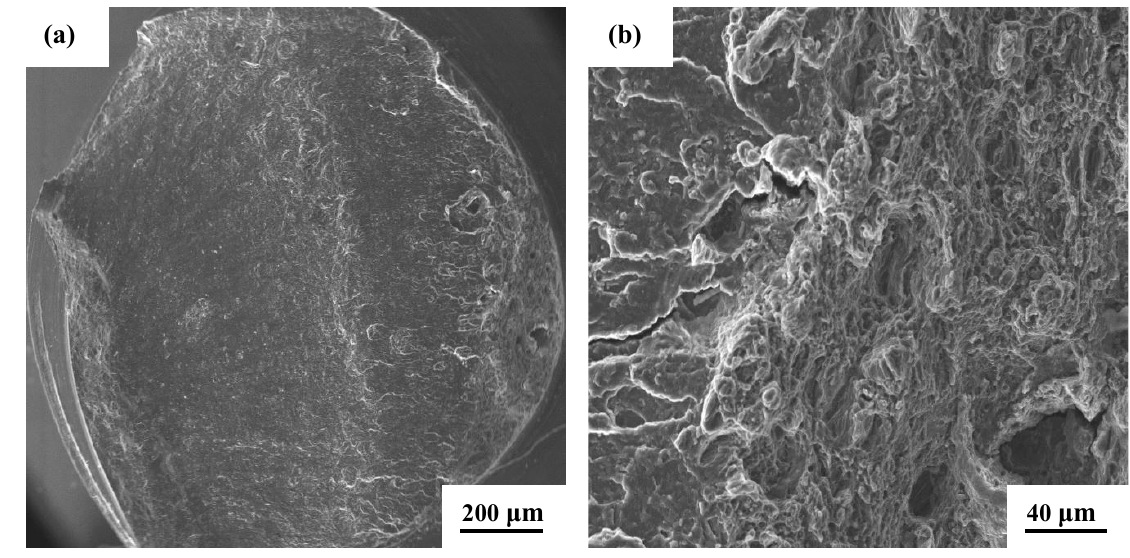
Figure 12. Scanning electron micrographs of the high cycle fatigue fracture surface of O containing 1.5 wt pct nickel deformed at maximum cyclic stress of AZ31 + Al 2 3 150.82 MPa at load ratio of − 1, fatigue life of 15,920 cycles, showing the following: ( a ) Overall morphology of fracture surface predominantly normal to the far field stress axis; ( b ) High magnification observation of (a) showing key intrinsic features in the region of early crack initiation and early microscopic crack growth; ( c ) Pockets of shallow, yet well defined striations in the region of stable crack growth and ( d ) The overload fracture surface revealing macroscopic void and crack interdispersed with shallow dimples of varying